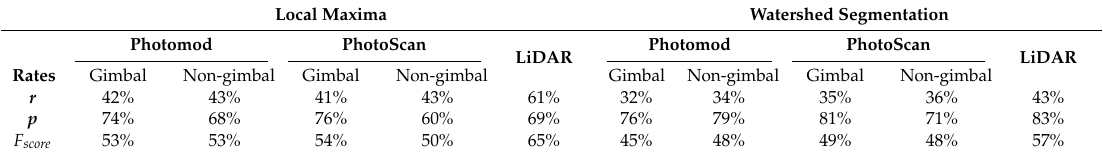
Table 4. Eucalyptus spp. tree ( n = 1277) detection rates (r) , using Equations (2)–(4), correctness of the detected trees ( p ), and overall accuracy ( F score ) based on local maxima and watershed segmentation results using raster 40-cm CHMs.